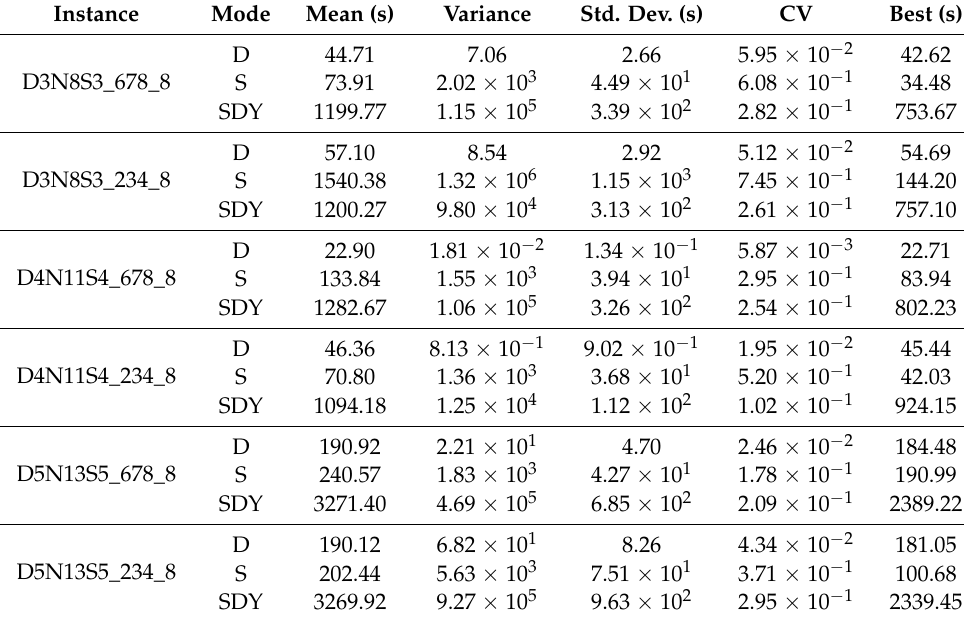
Table 10. Results of Computation Time with (Maximum) 8